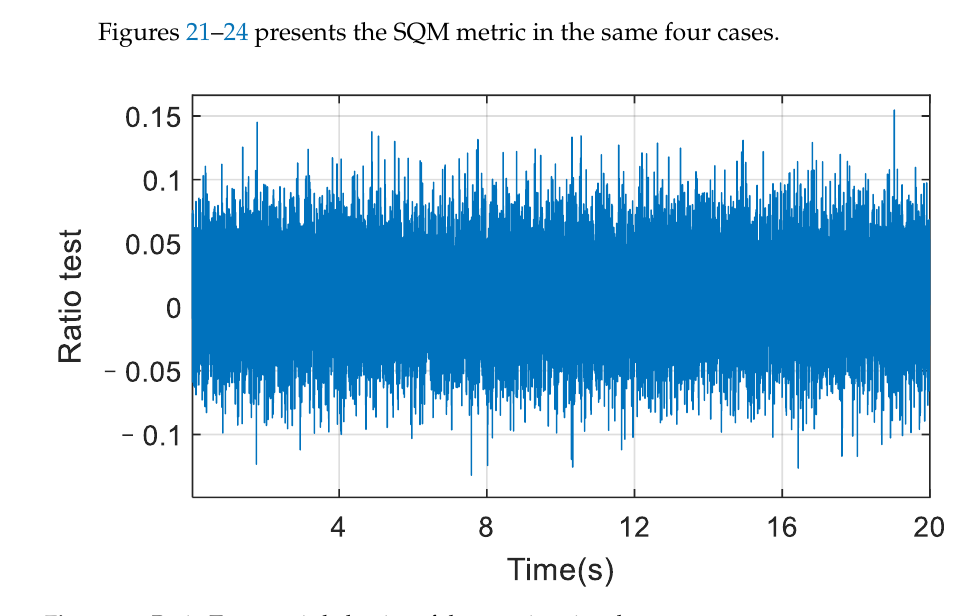
= 50 dBHz , D = 0.2). 0